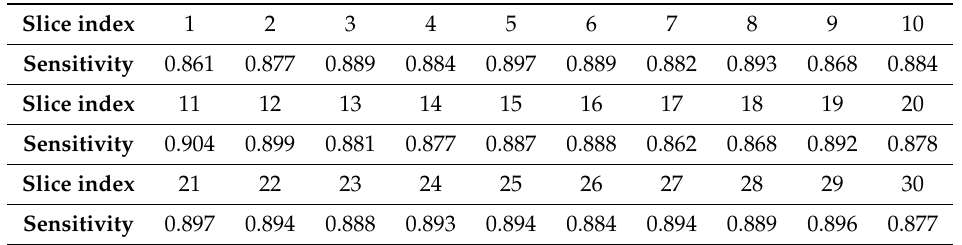
Table 2. Sensitivity measures obtained on several different samples of brain tumor from the dataset in Reference [65].